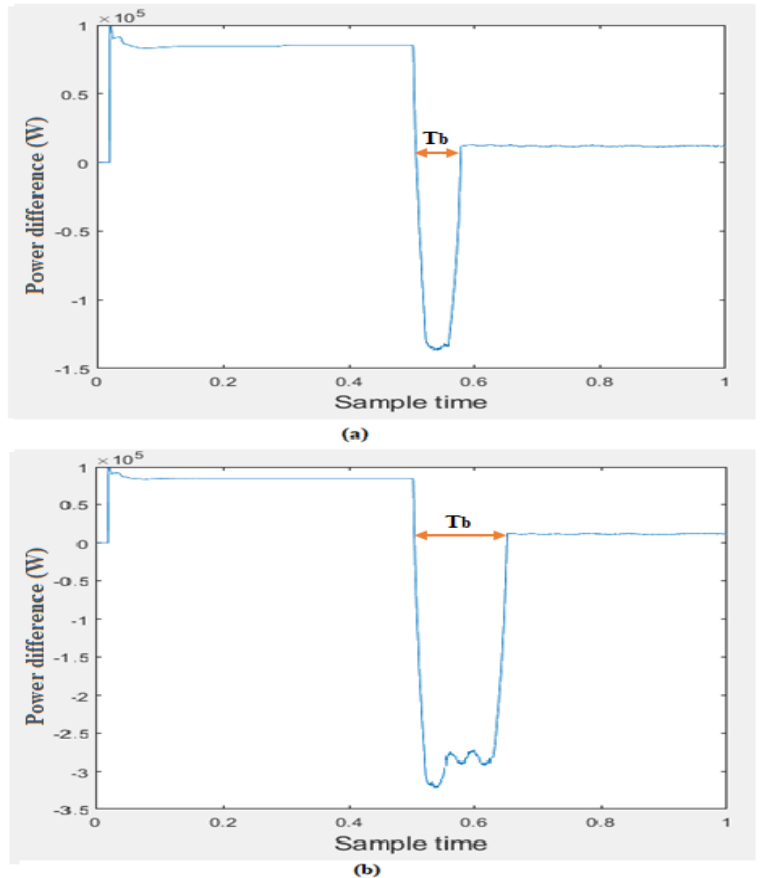
Figure 10. Total power difference, 𝛥𝑃 : ( a ) MG1, ( b ) MG2